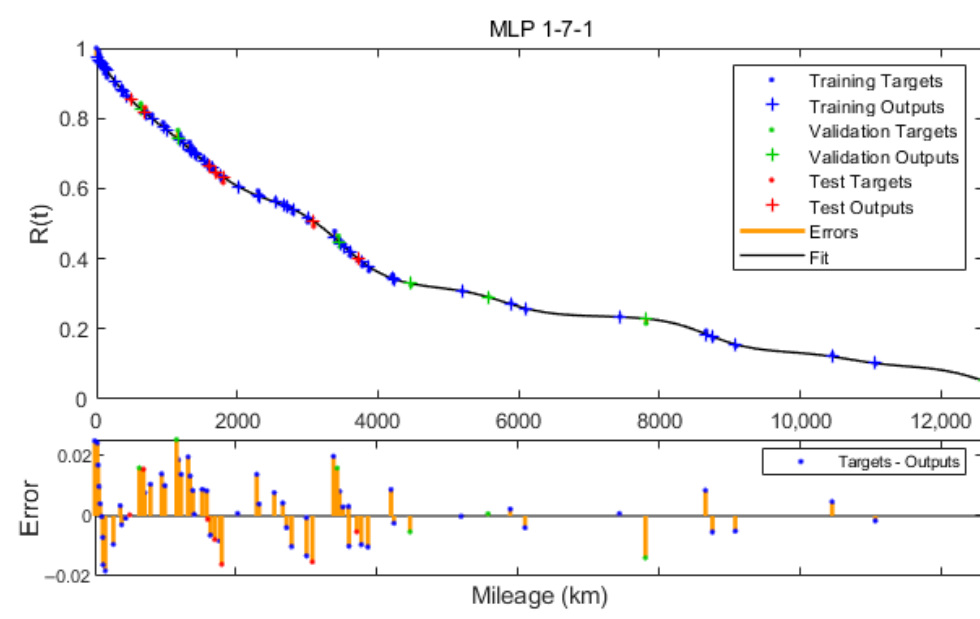
Figure A6. Reliability function approximated by MLP 1-7-1.